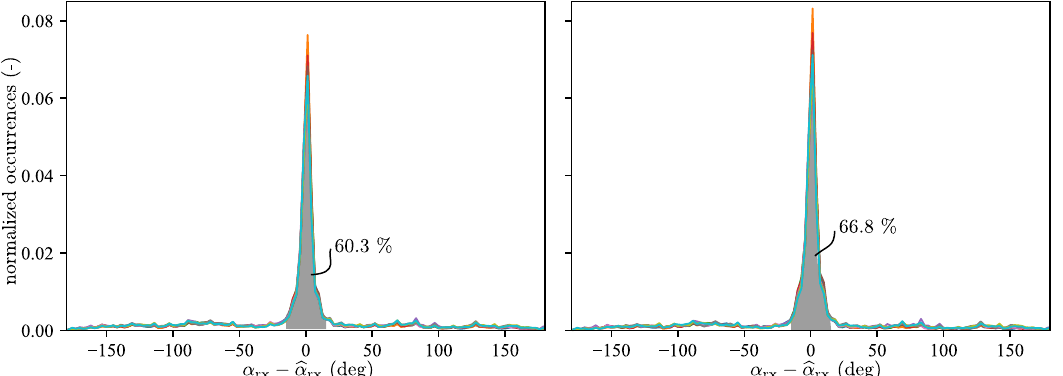
Figure A2. The error distribution of the maximum a-posteriori AOA estimate is shown for the ten different datasets using the Partron dielectric chip antenna with mounted carbon plates. On the left, the distribution is shown when the maximum a-posteriori estimate is calculated using a single CIR. On average 60.3% of the estimates have an error of less than 15 ◦ . This value is increased to 66.8% when the maximum a-posteriori estimate is calculated using ten consecutive CIR measurements as shown on the